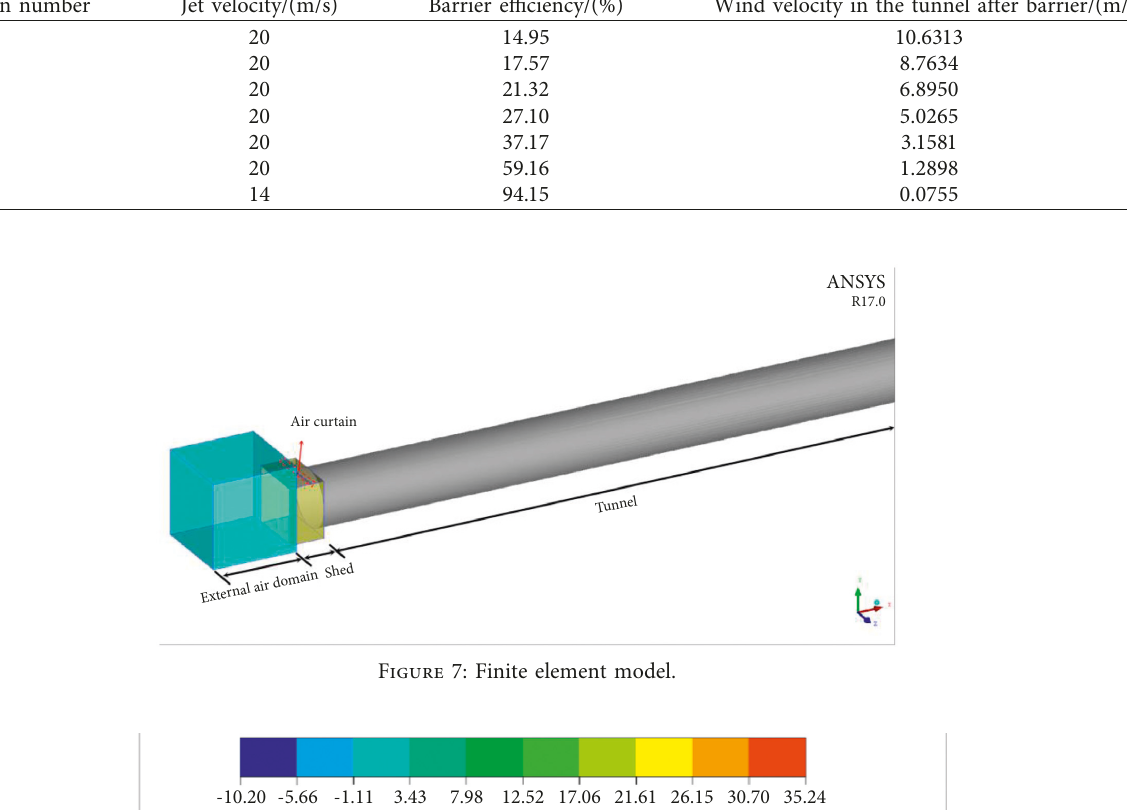
Table 6: Attenuation of natural wind velocity in the tunnel when the train passes at a speed of 200km/h. Air curtain number